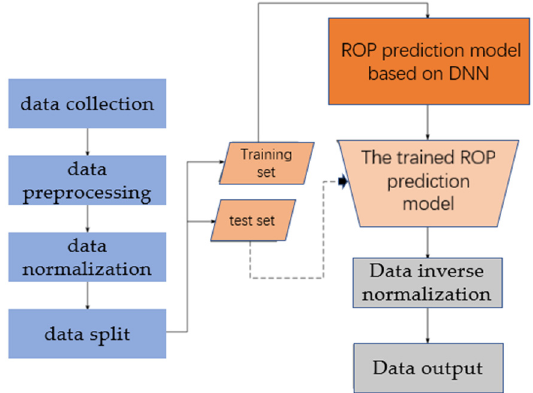
Figure 15. Calculation process.